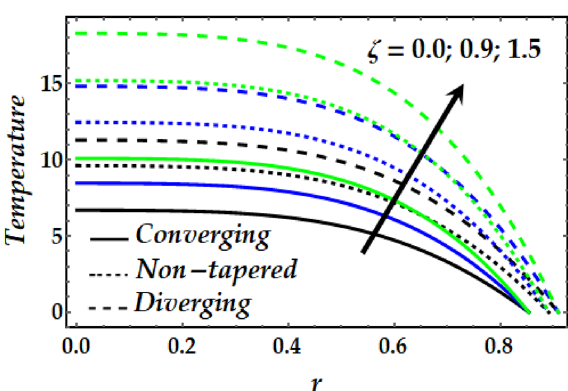
Figure 14. Temperature profile against distinct values of ζ